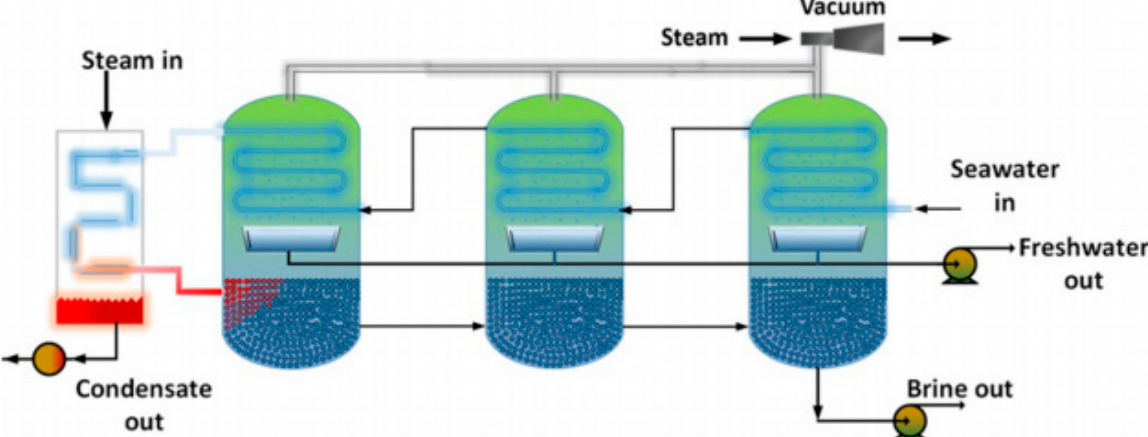
Figure 3. Schematic representation of the Multi-Stage Flash Distillation process, MSF. Source: Reproduced with permission from Ref. [32].